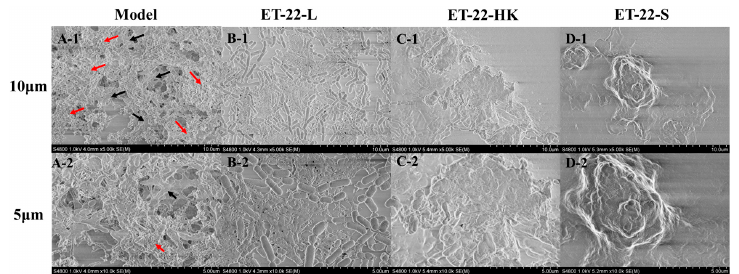
Figure 2. Biofilm microstructure of S. mutans after the co-culture with live bacteria (ET-22-V), heat- killed bacteria (ET-22-HK), and secretions (ET-22-S) of L. paracasei ET-22, produced using scanning electron microscopy. ( A-1 , A-2 ) are typical images of S. mutans biofilms in the Model group under a 10 µ m ( A-1 ) or 5 µ m ( A-2 ) scale. The red arrow points to the “corolla” of the cauliflower-like structure. The black arrow points to the “flower stalk” of the cauliflower-like structure. ( B-1 , B-2 ) are representative images of S. mutans biofilms after the co-culture with live L. paracasei ET-22 under a 10 µ m ( B-1 ) or 5 µ m ( B-2 ) scale. ( C-1 , C-2 ) are representative images of S. mutans biofilms after the co-treatment with heat-killed L. paracasei ET-22 under a 10 µ m ( C-1 ) or 5 µ m ( C-2 ) scale. ( D-1 , D-2 ) are representative images of S. mutans biofilms after the co-treatment with secretions of L. paracasei ET-22 under a 10 µ m ( D-1 ) or 5 µ m ( D-2 )